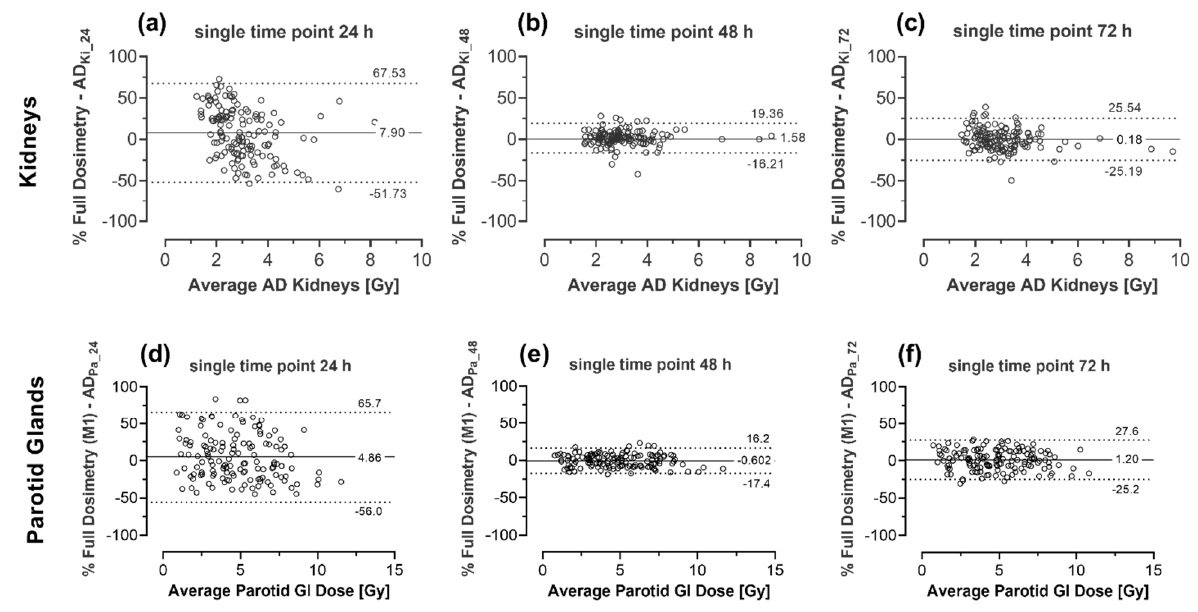
Figure 3. Bland-Altman-Analysis comparing calculated absorbed doses using full dosimetric scheme 1 (used as reference) and streamlined dosimetry (method 2) for single time-point imaging at 24, 48 and 72 h p.i. for kidneys ( a – c ) and parotid glands ( d – f ). The solid line shows the mean bias between the two methods, whereas dotted lines show the 95% limits of agreement. Table 4. Results of Bland-Altman-Analysis (method 1 as reference) for cycles 2 to 6 showing mean bias and 95% limits of agreement between method 1 and method 2 for AD of kidneys and parotid glands using single time-point imaging at 24, 48 and 72 h p.i. Data are given as mean ± SD (min to max of 95% limits of agreement). Kidneys Parotid